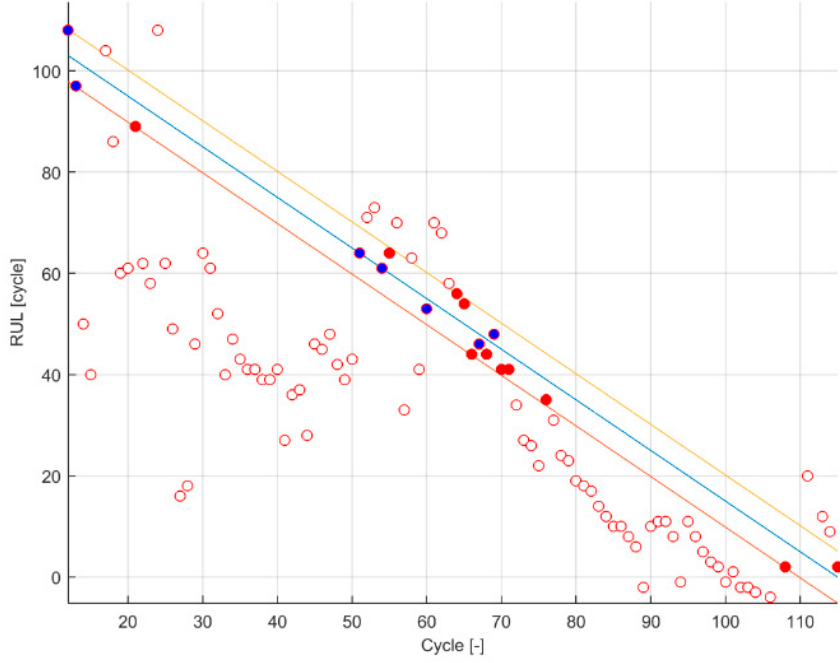
Figure 8. Results from test nº 4 (“B0018” modelled with a double exponential). The highest PH values are calculated on the tests 2 and 4 with a “perfect” one. This means that the tracking of the correct aging trend underneath of the data set B0018 can be done in the earliest selected prediction-time-instant. The test 1 and 3 shows lower PH val- ues than the obtained in the tests 2 and 4. However, the obtained scores are above 0.8, which are high values by themselves. In this case, the test 3 shows a higher value than the